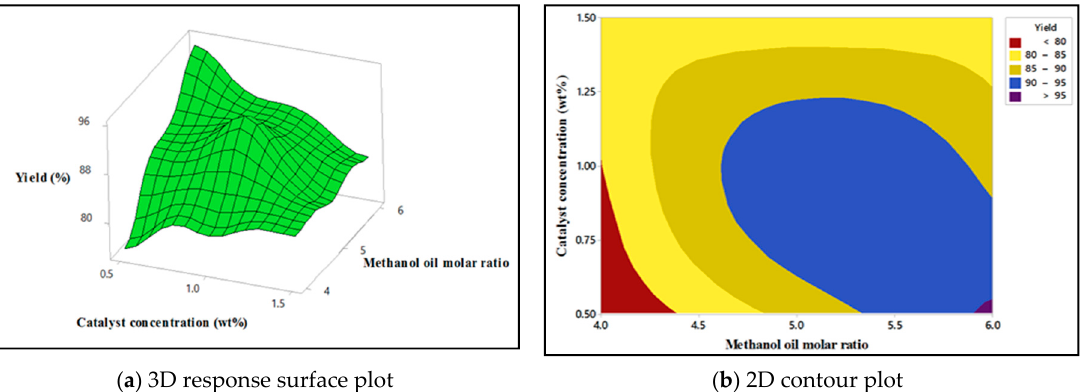
Figure 6. Interaction effect of methanol: oil molar ratio (M) and catalyst concentration (C) on the SFO biodiesel yield.